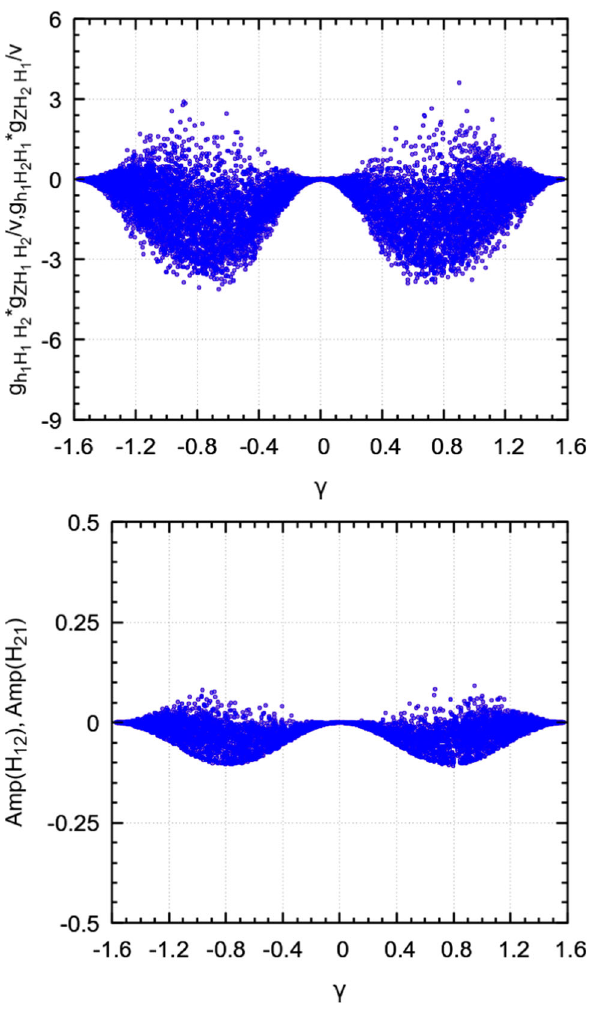
Fig. 8 Results (red dots) for the sum of all charged scalar amplitudes contributing to h → Z γ , as a function of the mixing angle γ . On the and H ± running in 1 2 upper panel the sum of the product of couplings and on the lower panel the complete